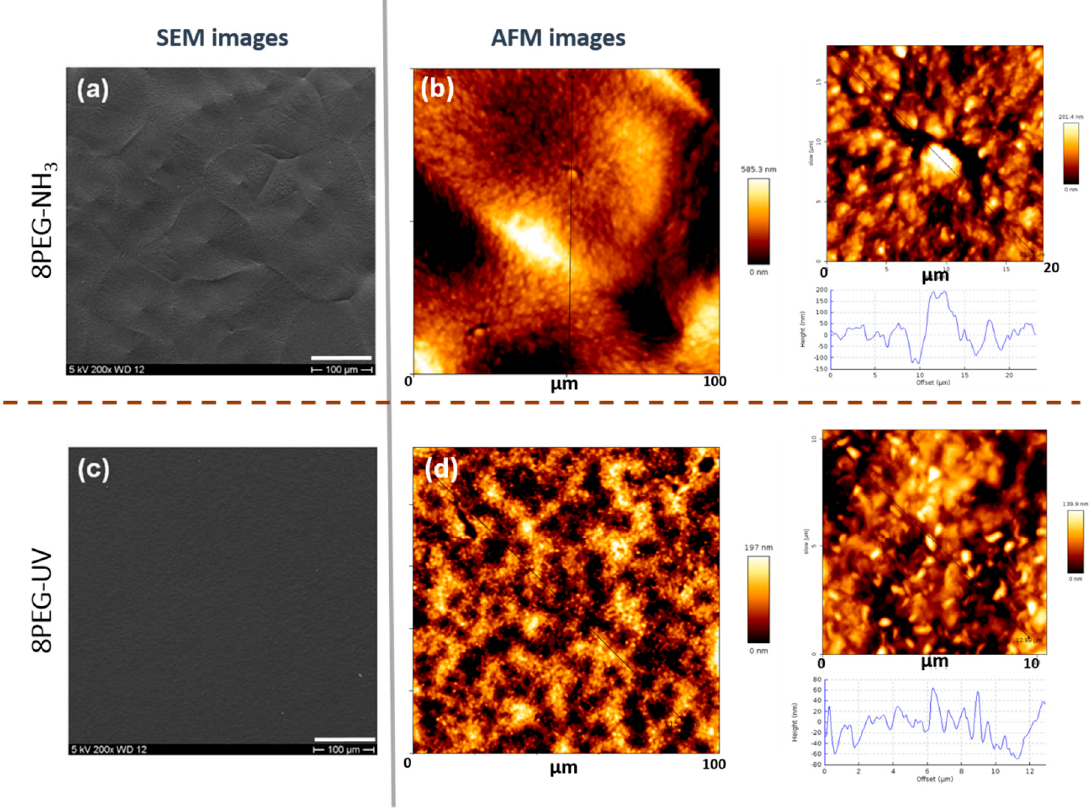
Figure 4. Representative SEM and AFM images of 8PEG–NH3 ( a , b ), and 8PEG–UV ( c , d ) hydrogels. As ‐ prepared samples were dried in air prior to the measurements (SEM in vacuum and AFM in air). Scale bars ( a , c ) 100 μ m.